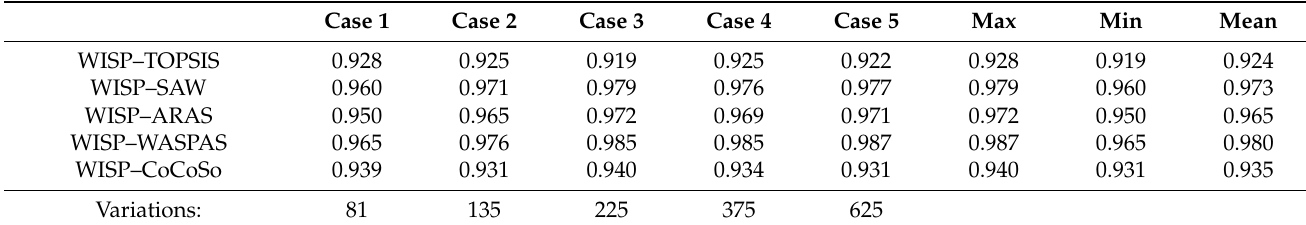
Table 11. The correlation between the best-ranked alternatives.